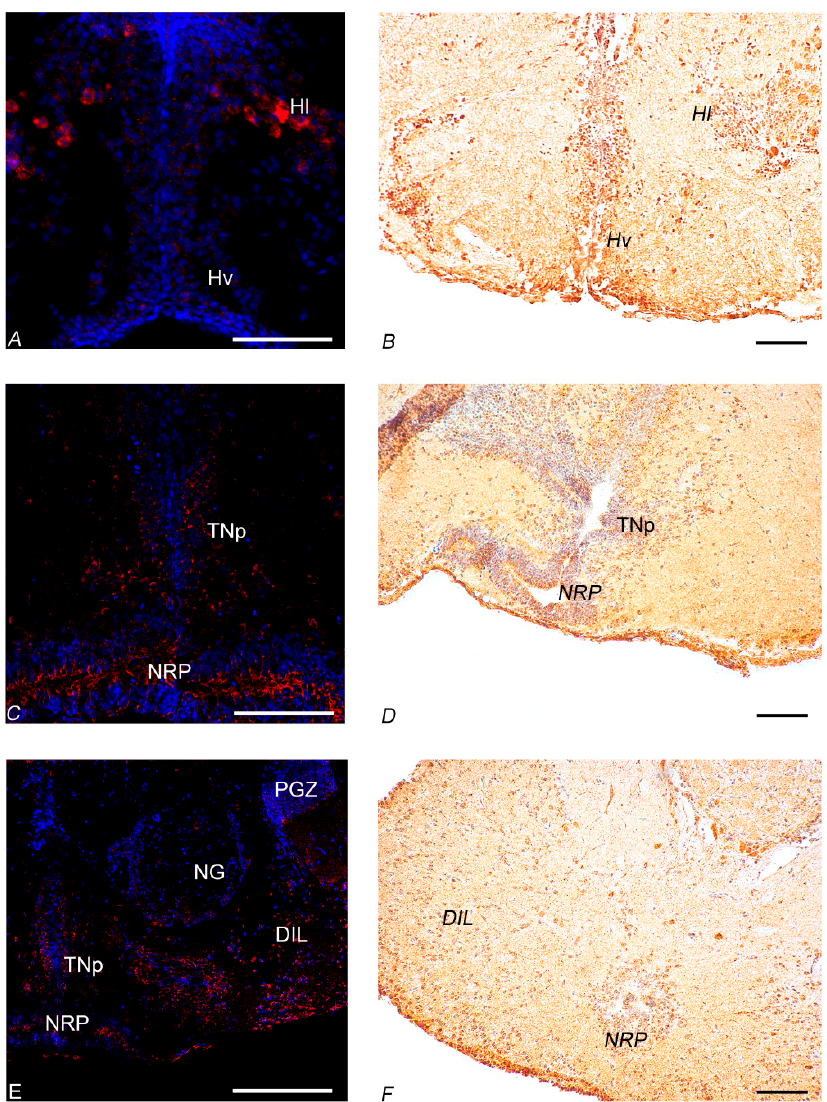
Figure 5. Transversal section showing localization of NUCB2B mRNA and Nesf-1 protein in the brain of old N. furzeri . ( A ) NUCB2B expressing neurons in HI and Hv; ( B ) Nesf-1 immunoreactivity (ir) in neurons of HI and Hv; ( C ) NUCB2B expressing neurons in TNp and NRP; ( D ) Nesf-1 ir in neurons of NRP and TNp; ( E ) NUCB2B expressing neurons in DIL, NG, NRP, PGZ, and TNp; ( F ) Nesf-1 ir-neurons of DIL and NRP. Scale bars: A-C-E 200 µm, B-D-F 100µm.